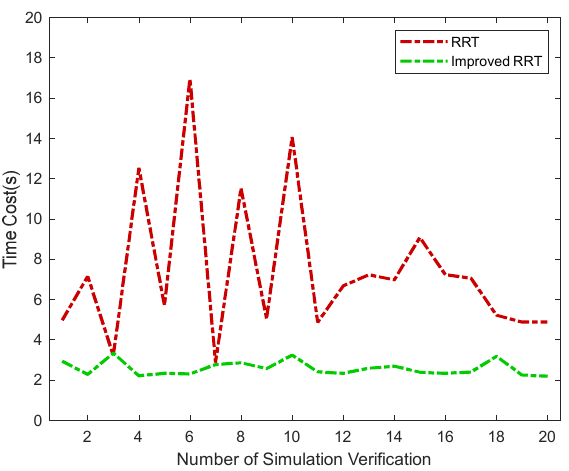
Figure 15. Comparison of the time costs of the two algorithms.